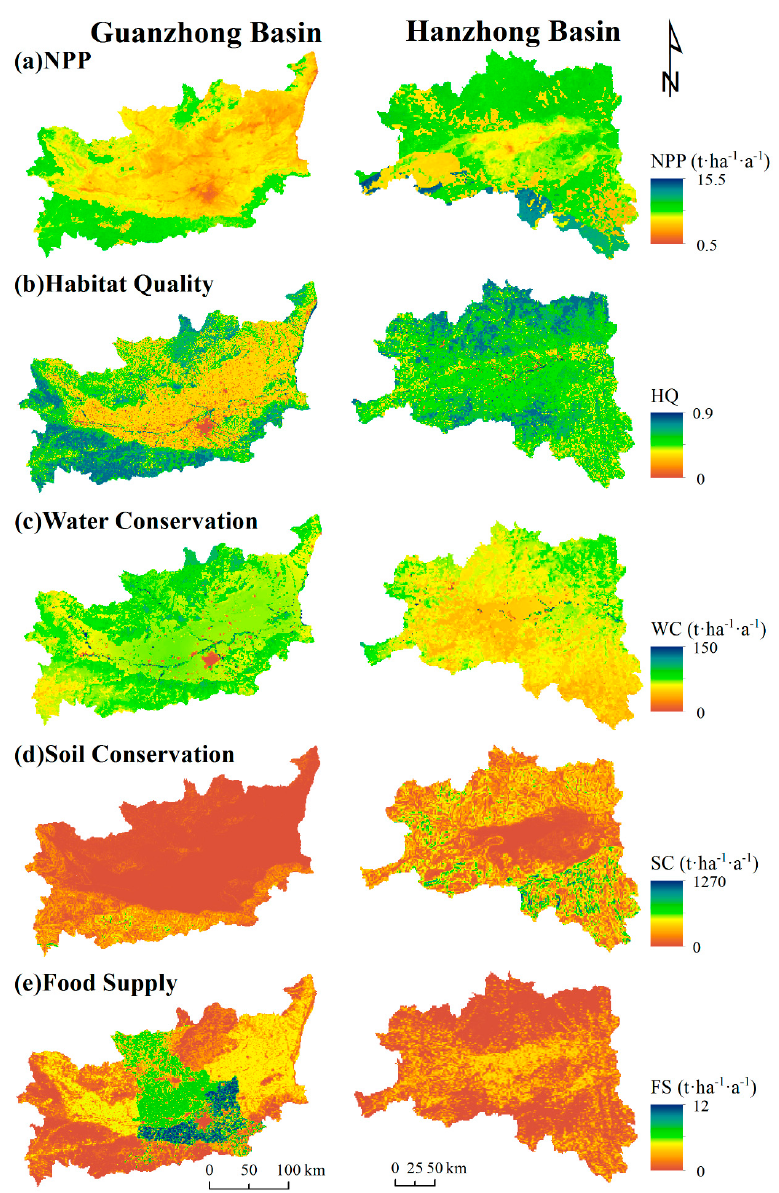
Figure 2. The spatial distribution of average ecosystem services in valley basins from 2000 to 2018.